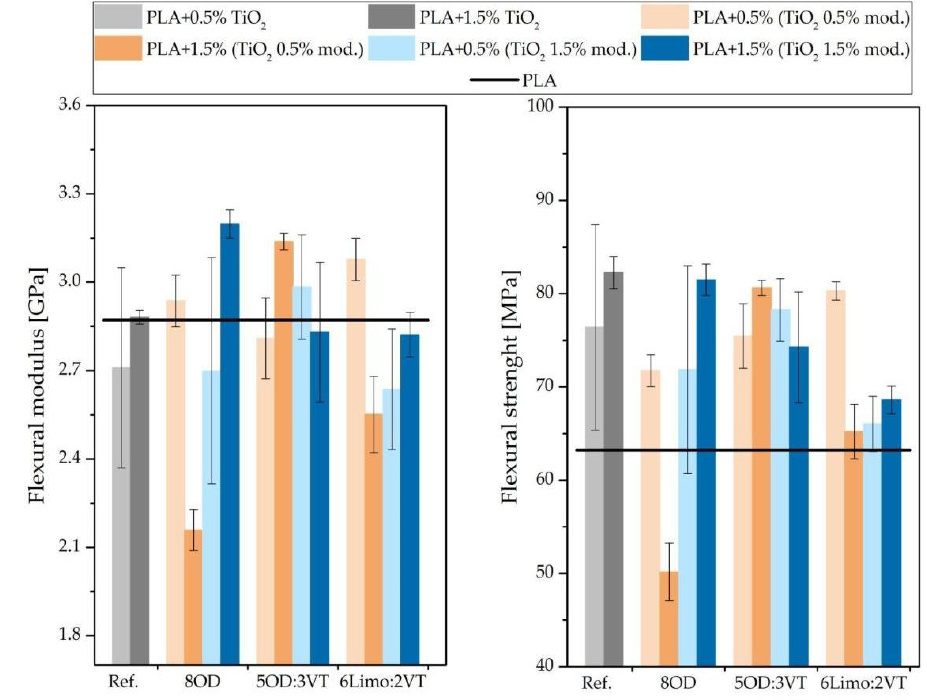
Figure 11. Flexural modulus and flexural strength tested sample.